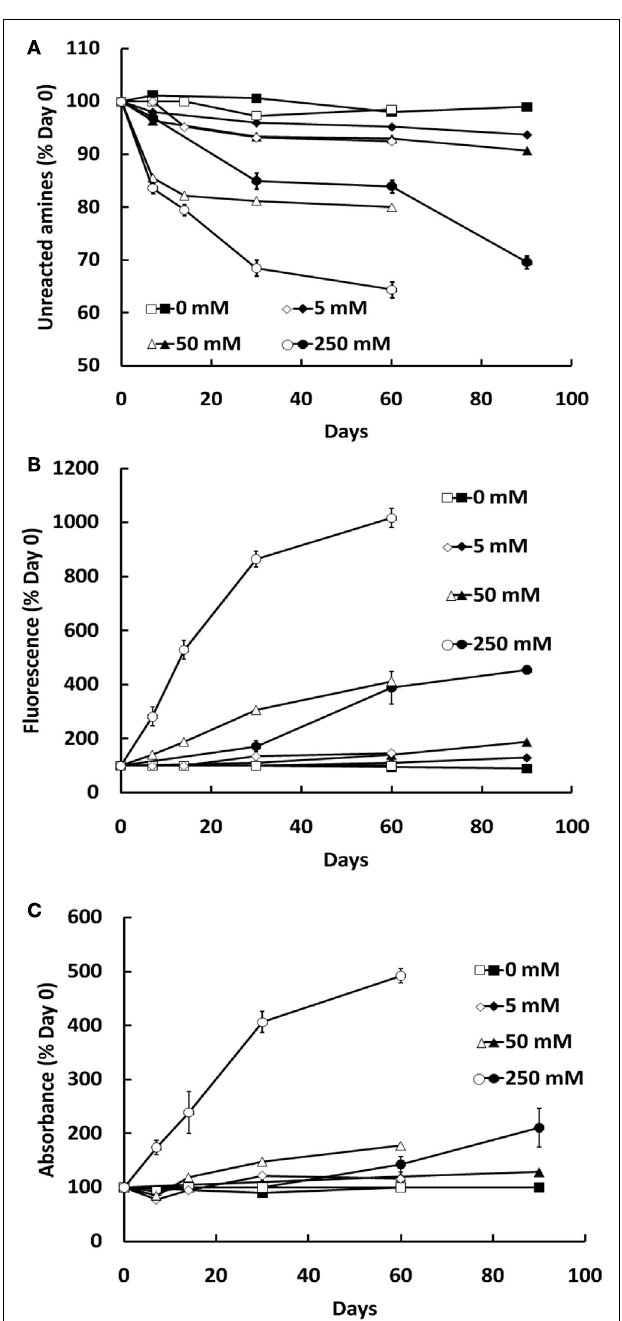
FIGURE 1 | Glycation of BSA (10mg/ml) during co-incubation with G6P (open symbols) or glucose (filled symbols), as assessed by the decline in free amine groups (A), sample fluorescence (B), and sample absorbance (C). Symbols represent the mean ± SEM for three separate batches of BSA glycated under identical conditions and each sample was read in triplicate.